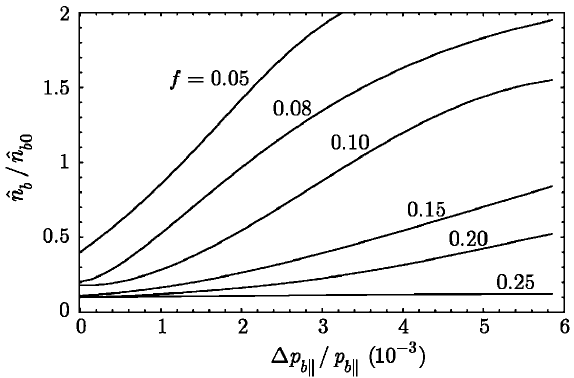
FIG. 4. Linear and nonlinear phases of the e - p two-stream instability. Plotted is the time history of density perturbation for the (a) protons and (b) electrons at a fixed spatial